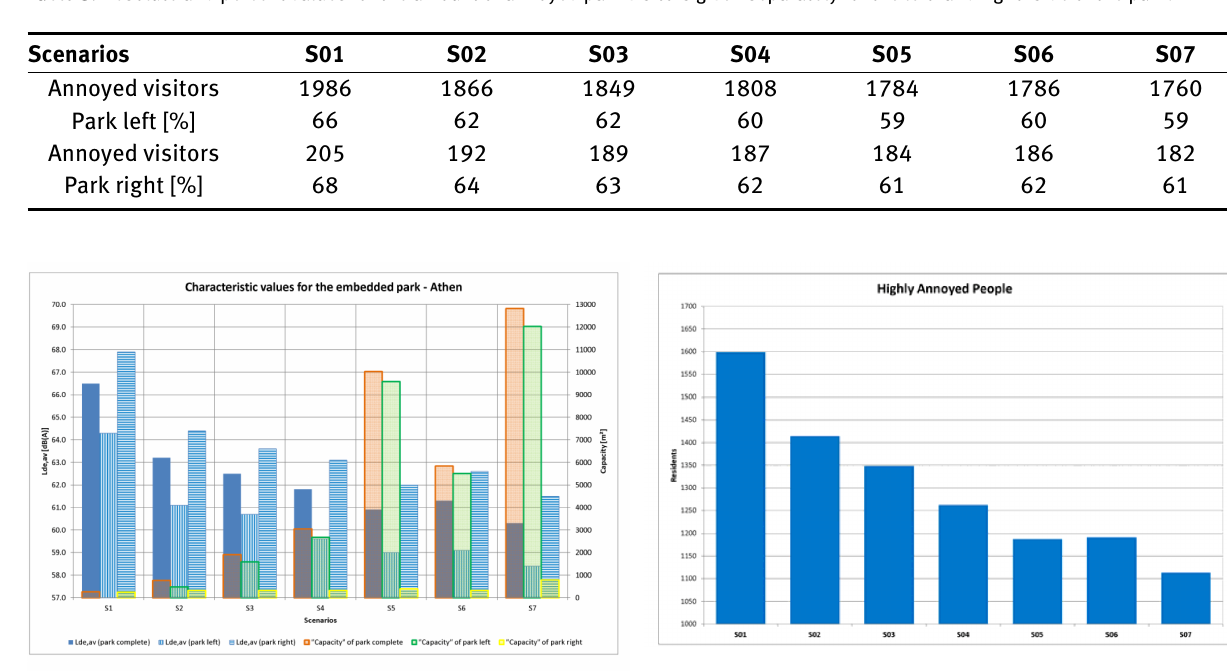
Figure 24: Amount of HAP in the various scenario configurations in the Q-Zone.